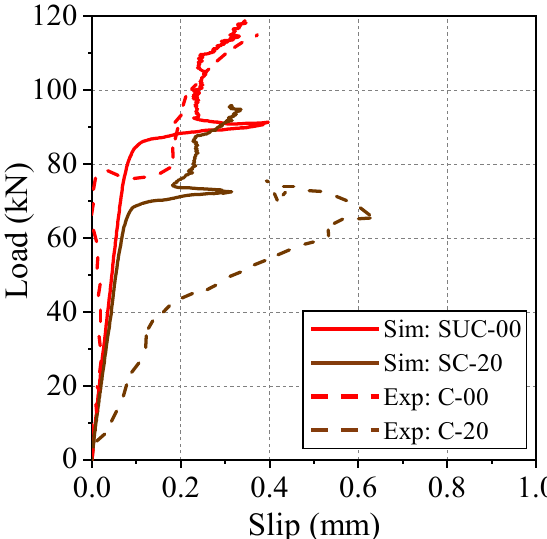
Figure 8. Comparison of slipping behavior between simulation and experiment.